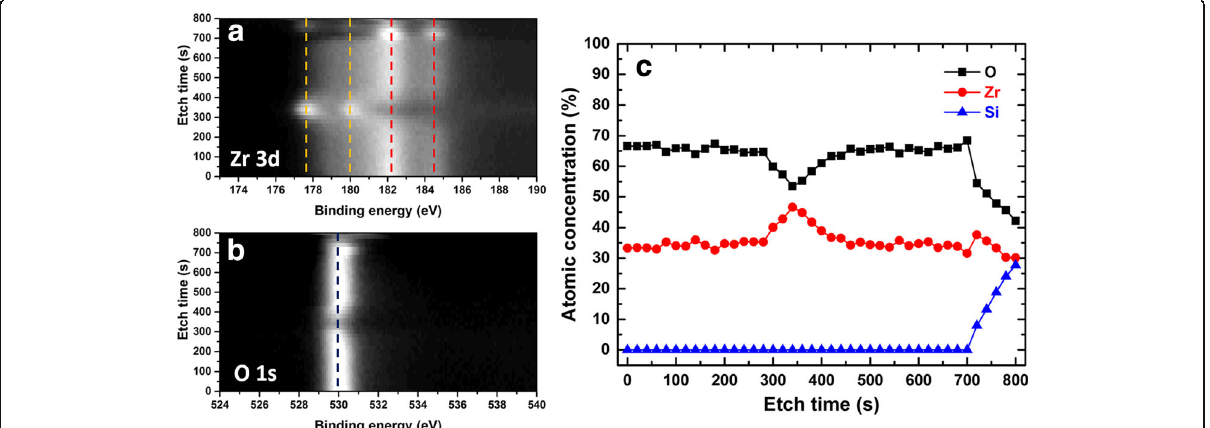
Fig. 2 XPS spectra of a Zr 3d and b O 1s for the ZrO 2 /ZrO 2 − x /ZrO 2 tri-layer structure over an etch time of 700 s. c XPS depth profile of the ZrO 2 /ZrO 2 − x /ZrO 2 tri-layer